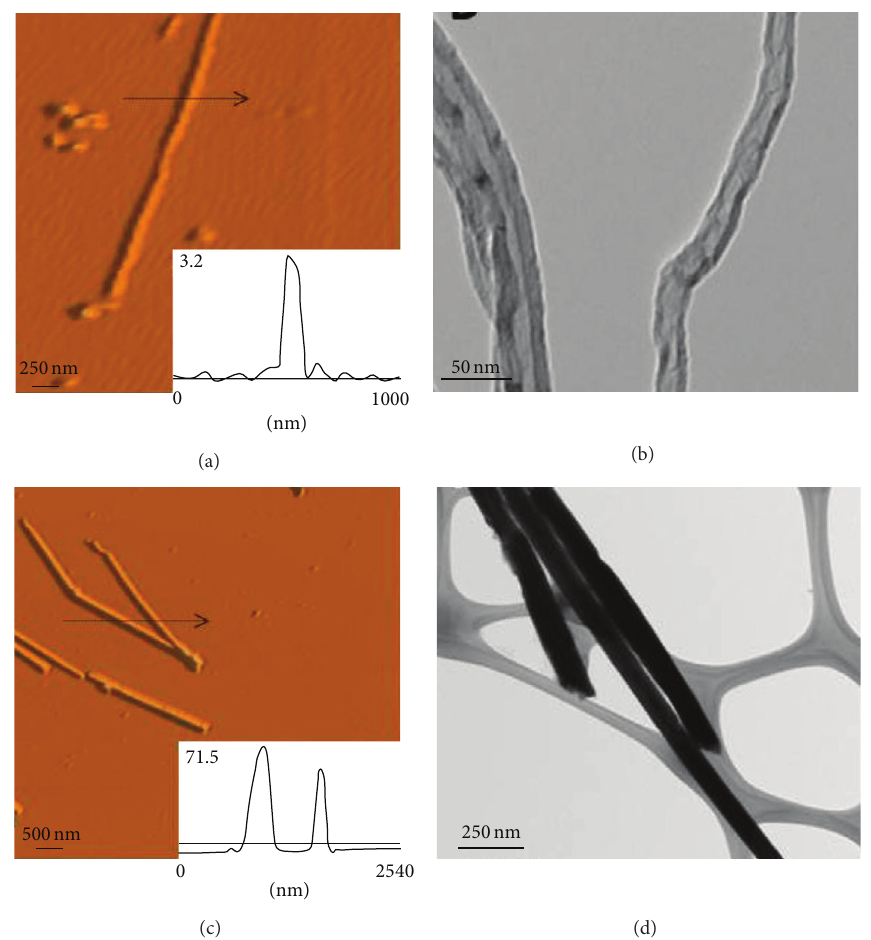
Figure 4: AFM and TEM images of MWCNTs ((a) and (b)) and WSNTs ((c) and (d)). The insets in (a) and (c) show the corresponding height ( 𝑍 ) profiles [41].